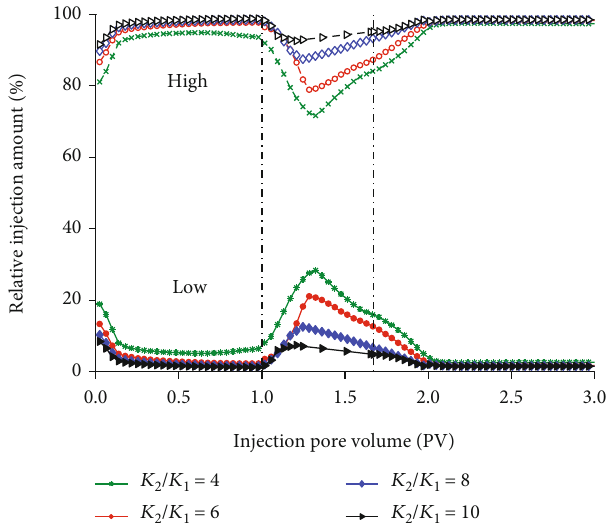
Figure 7: Injection conformance behavior for reservoirs with di ff erent permeability contrast.